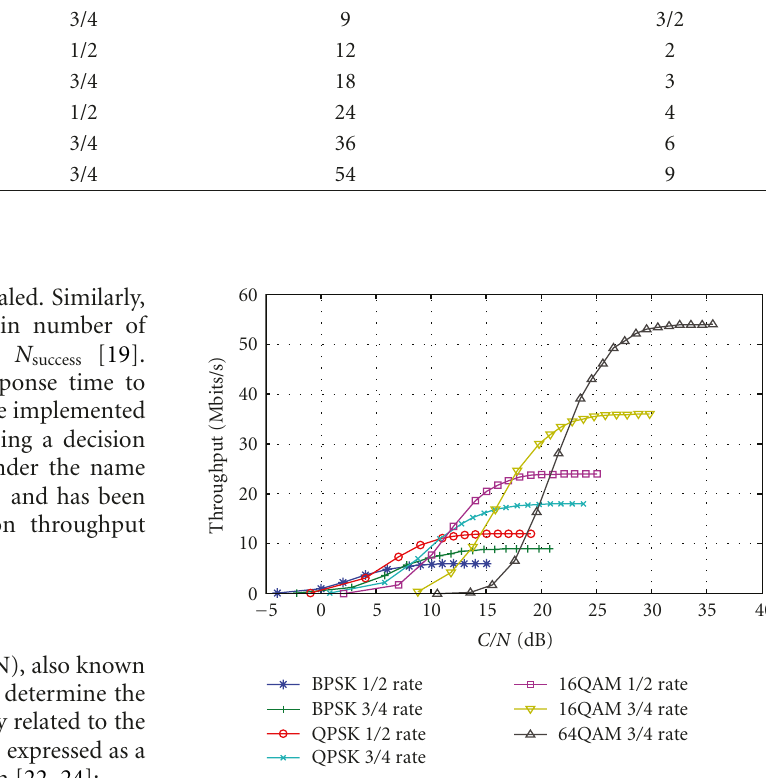
Figure 2: Link adaptation based on throughput, IEEE 802.11a/g, 825 byte